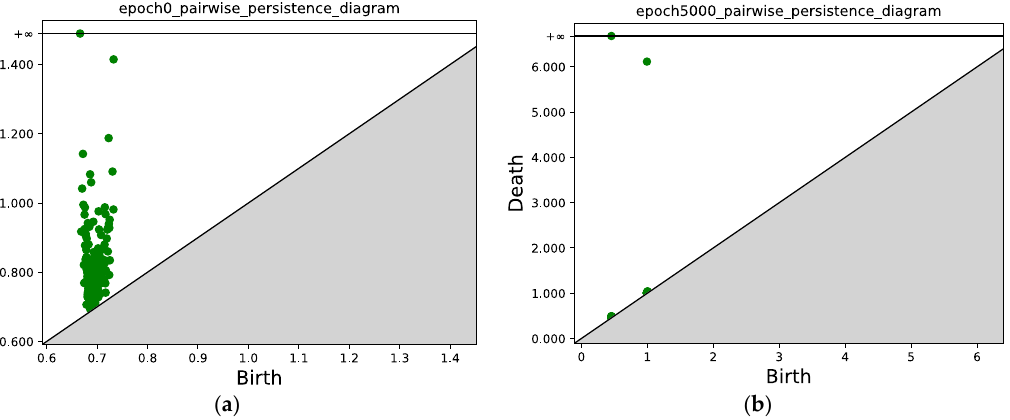
Figure 7. ( a ) Persistence diagram obtained via persistent homology at epoch 0; ( b ) Persistence dia ‐ gram after 5000 epochs. Two connected components can be identified, the points with x ≈ 0.5 corre ‐ spond to the first connected component (class 1), and the points with x ≈ 1.0 correspond to the sec ‐ ond connected component (class 2).